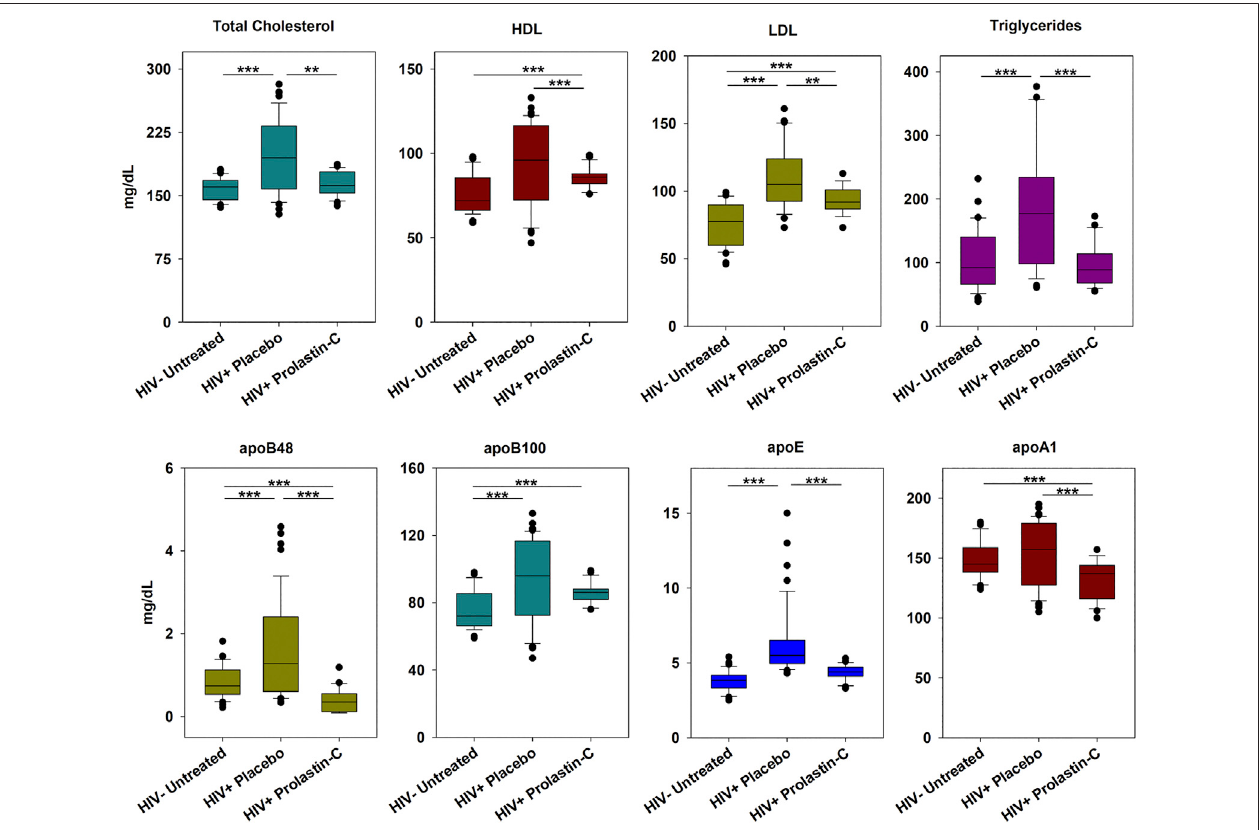
FIGURE 1 | Prolastin-C treatment in HIV-1-infected individuals decreases circulating levels of lipoproteins other than apoB100. At baseline and each week for 8 weeks oftreatment, individuals wereassessed for lipoprotein levels. The clinical trial was composed of3arms: uninfected, uninfected (n (cid:1) 4), HIV-1 infected, placebo- treated(n (cid:1) 5),andHIV-1infected,Prolastin-Ctreated(n (cid:1) 3),andmeasurementsforeacharmcontainn (cid:1) 36,n (cid:1) 45,andn (cid:1) 27,respectivelywiththeexceptionofLDL. One individual in the placebo arm and one in the Prolastin-C arm were omitted from analysis of LDL levels due to their treatment with LDL-lowering statin medications resulting in n (cid:1) 36 and n (cid:1) 18 measurements, respectively. Apolipoproteins were not normally distributed, and medians were compared using one-way Kruskal-Wallis analysis of variance on ranks and the Mann-Whitney Rank Sum Test to determine signi fi cance of differences between individual treatment groups. Medians aredepictedwithinboxplots.Thepower oftestforallstatisticalanalysesexceeded0.8suggestingthatsamplesizewassuf fi cientlylargetoobtainsigni fi cance. Asterisks designate a statistically signi fi cant difference, ** p < 0.01, *** p <